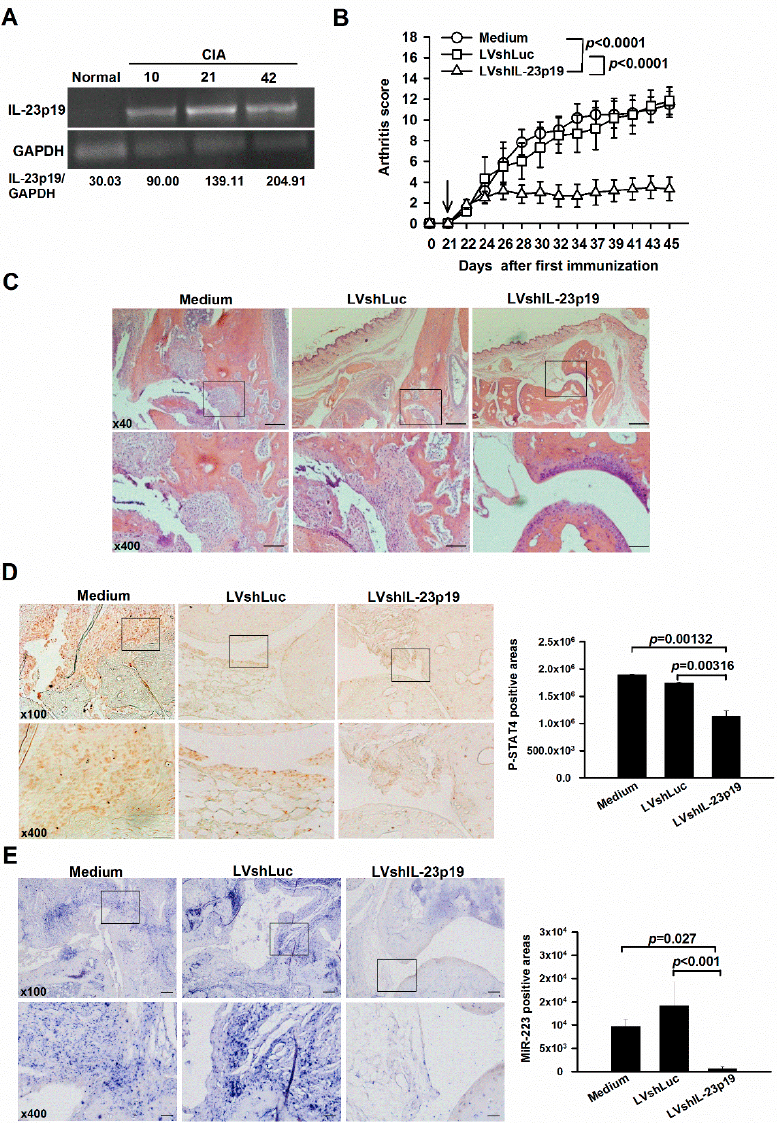
Figure 1. Endogenous expression of IL-23p19 and clinical assessments in the LVshIL-23p19-treated mice with collagen-induced arthritis (CIA). ( A ) Reverse transcription polymerase chain reaction (RT-PCR) analysis of IL-23p19 expression in the synovial tissue of mice with CIA (Day 10, 21, 42). Each lane represents pooled samples from 3 animals. Results are representative of two independent experiments. ( B ) Amelioration in mice with CIA by evaluating with arthritis score after the LVshIL-23p19 treatment. Mice that had been immunized with collagen on days 0 and 21 were injected intraperitoneally with LVshIL-23p19, LVshLuc and medium on day 21, respectively. The arrow indicates the time at which the lentiviral vectors were injected. Each value shown represents the mean ± SEM ( n = 6). ( C ) Representative images of the ankle sections by hematoxylin and eosin staining on day 45. ( D ) Representative images and quantification of the levels of phosphorylated signal transducers and activators of transcription 4 (p-STAT4) by immunohistochemical staining on day 45. Each value shown represents the mean ± SEM ( n = 3). ( E ) Representative images of the levels of miR-223 by in situ hybridization on day 45. Scale bars represent 500, 200 and 50 µ m in × 40, × 100 and × 400 magnifications, respectively. Each value shown represents the mean ± SEM ( n = 3). Black boxed areas were shown at higher magnification in the panels ( × 400) beneath them. Results are representative of two independent